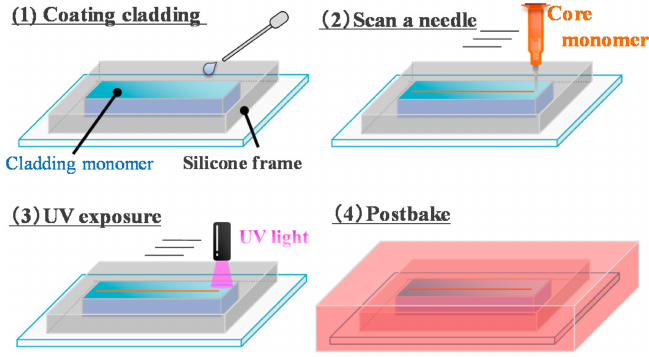
Figure 1. Procedures in the Mosquito method.